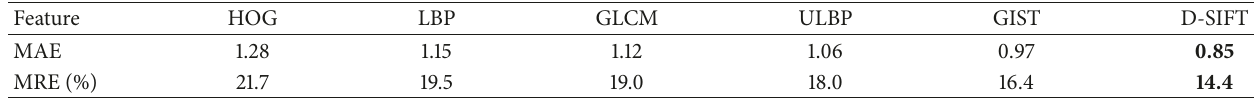
Table 1: Comparison between different individual features.